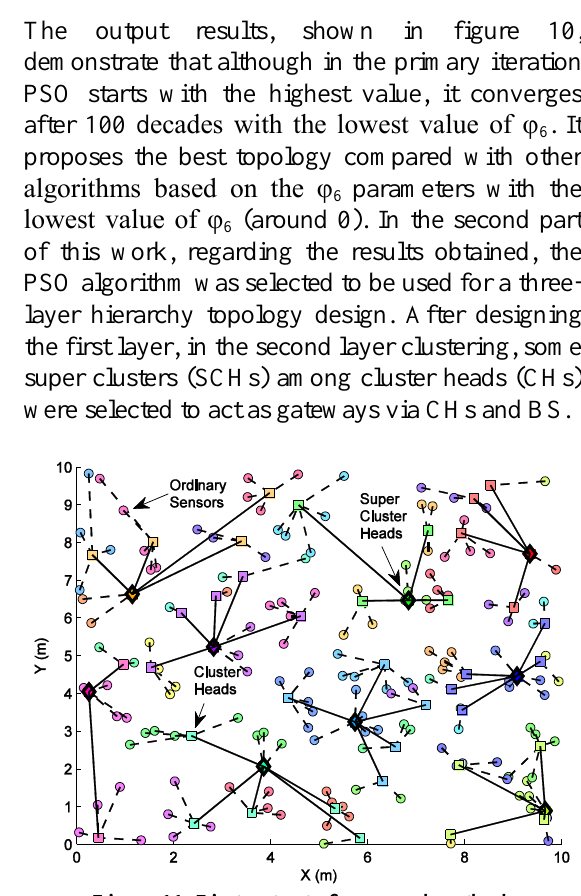
Figure 11. First output of proposed